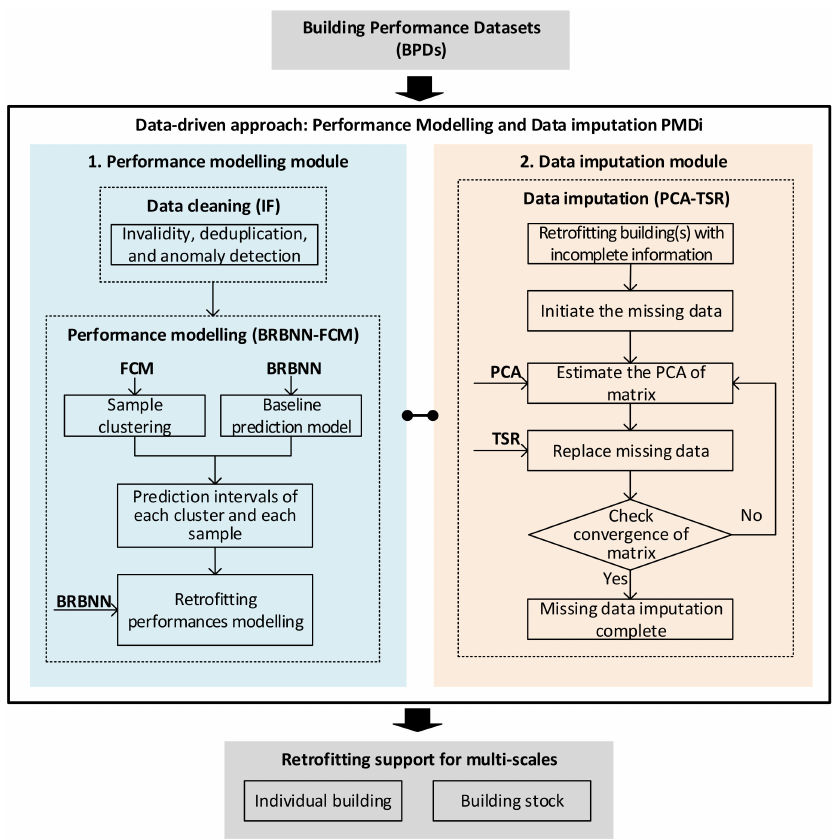
Figure 1. The overall framework of the proposed PMDI data-driven